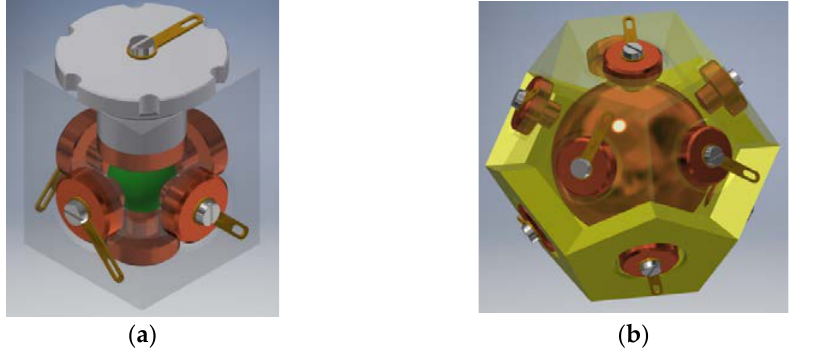
Figure 12. Tilt sensors based on the Platonic solids: ( a ) cuboidal sensor; ( b ) dodecahedral sensor .